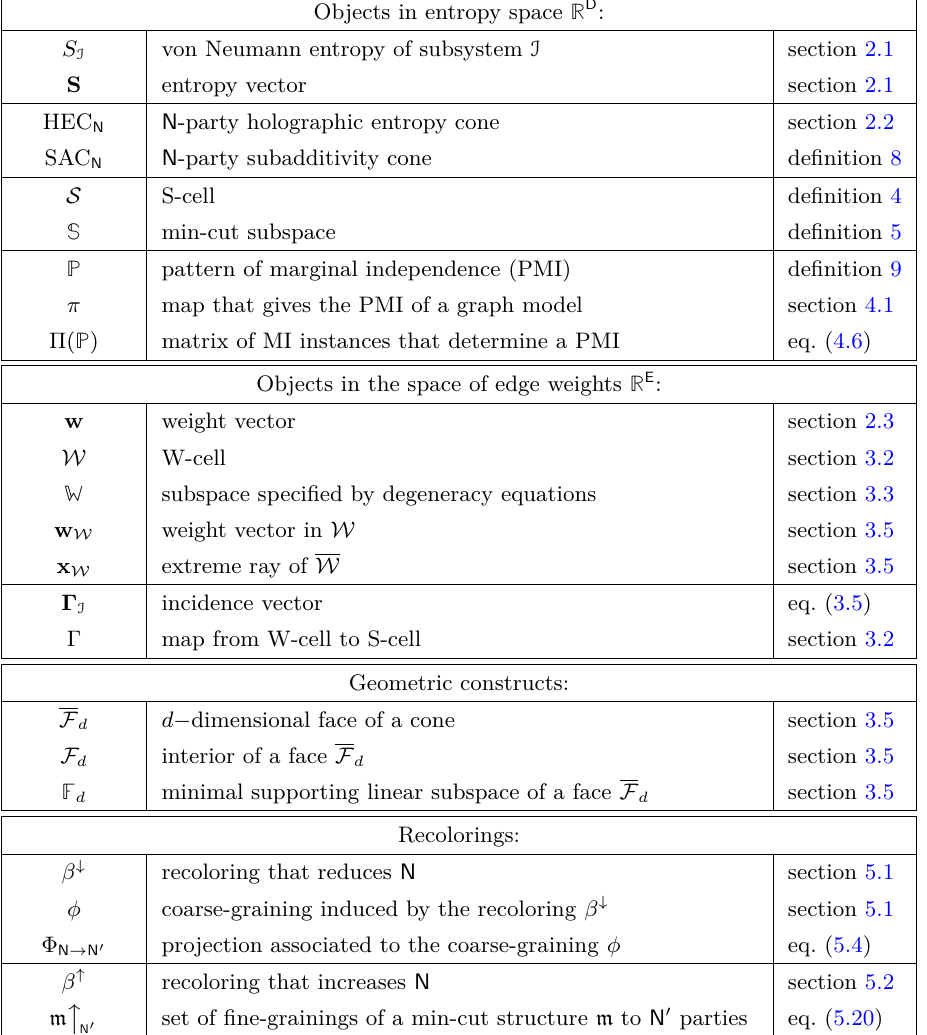
Table 1. A reference table summarizing the main notation and terminology used. To facilitate orientation, we typically reserve sans-serif font for natural numbers, mathcal for geometrical regions, mathbb for linear subspaces, bold face letters for vectors, mathscript for sets, and mathfrak for more complicated but important